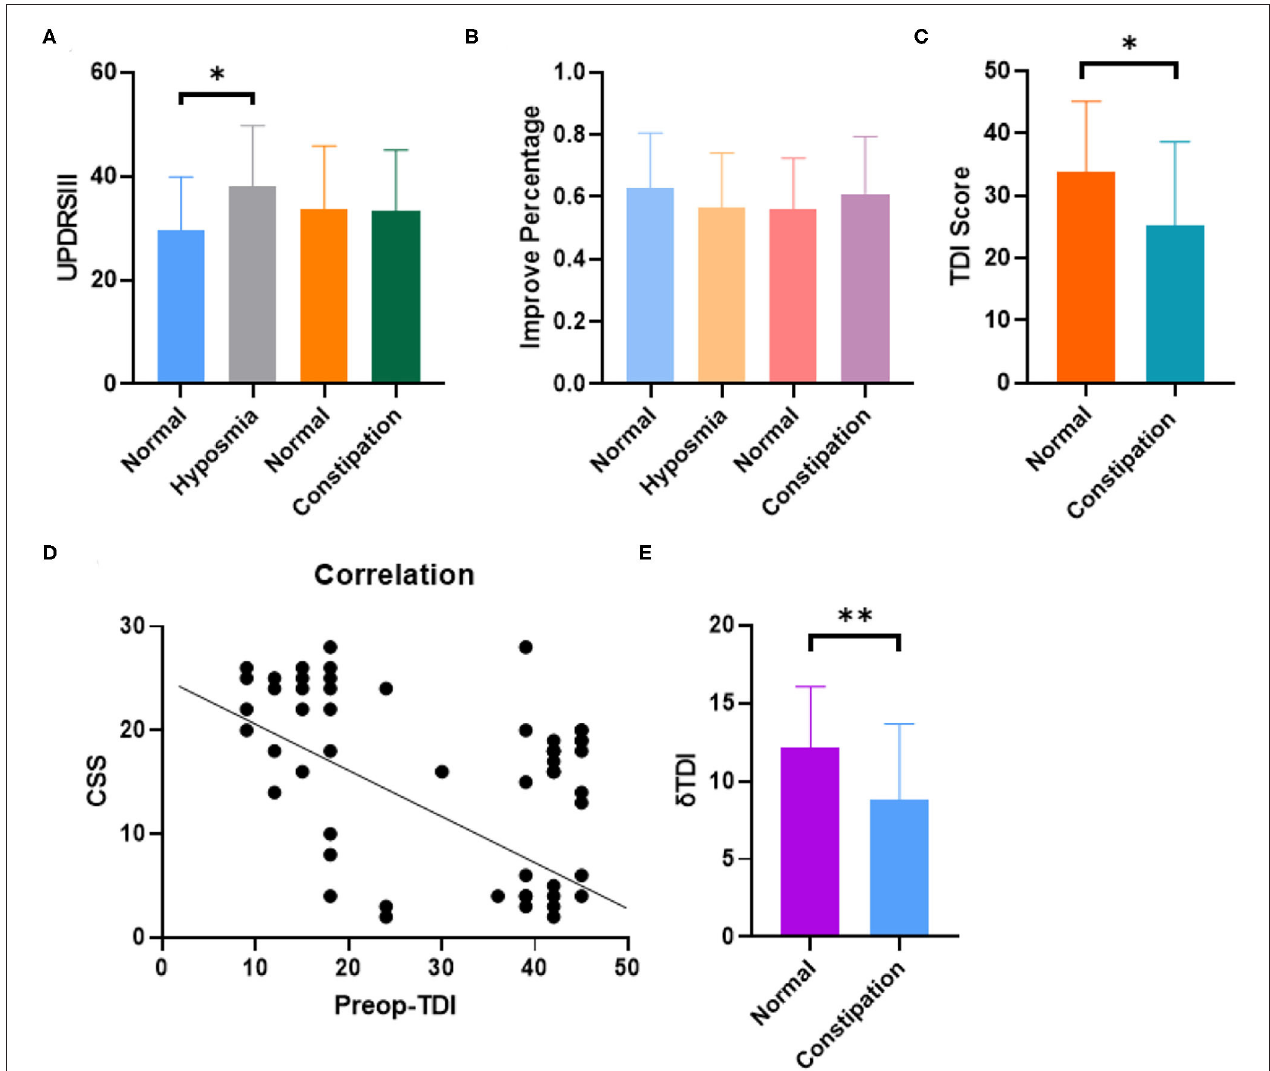
FIGURE 2 | The rate of oldness disorder in PD patients with constipation was significantly increased, and the two scores were correlated to a certain extent, while the improvement of oldness score after DBS in patients with constipation was not ideal. (A) Hyposmia group showed higher UPDRSIII score and no obvious difference was observed in constipation and non-constipation group ( P = 0.0381 Unpaired student’s t -test. Error bar = mean ± standard deviation). (B) No obvious difference was observed in DBS improvement percentage within different groups (Error bar = mean ± standard deviation). (C) The olfactory function score is lower in constipation group than control group ( P = 0.0145 Unpaired student’s t -test. Error bar = mean ± standard deviation). (D) Constipation and hyposmia had negative correlation with each other (spearman, r = − 0.4776, p < 0.01). (E) Constipation group had lower δ TDI score indicating that PD patients with constipation got less therapeutic effect on hyposmia from DBS ( P = 0.0072 Unpaired student’s t -test. Error bar = mean ± standard deviation). * p < 0.05 and ** p <